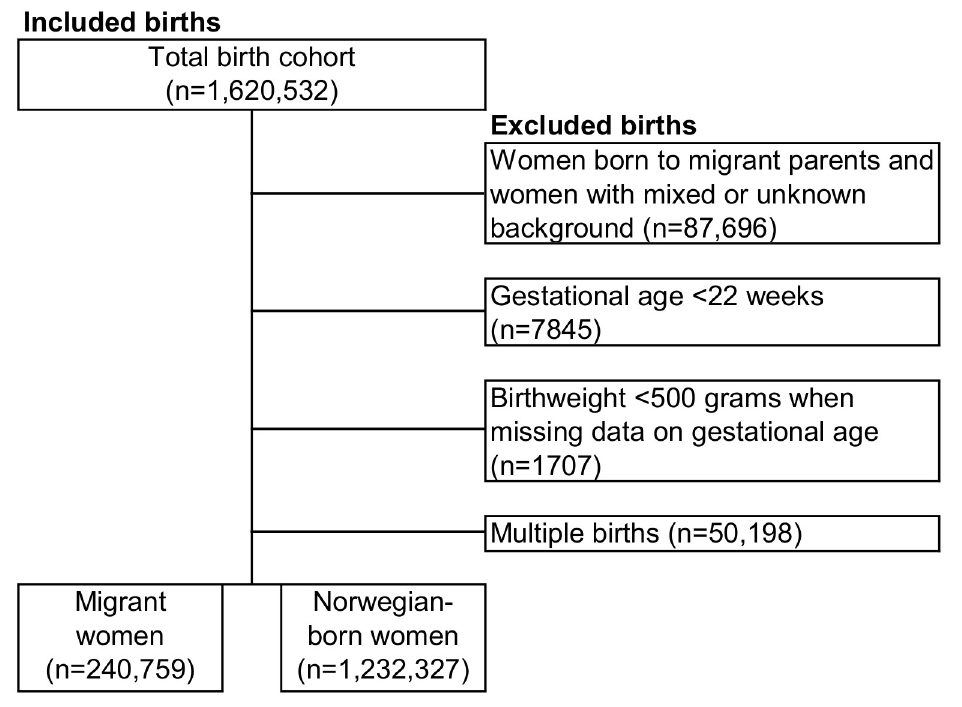
Fig 1. Flowchart of the derivation of the study sample (n = 1,620,532).